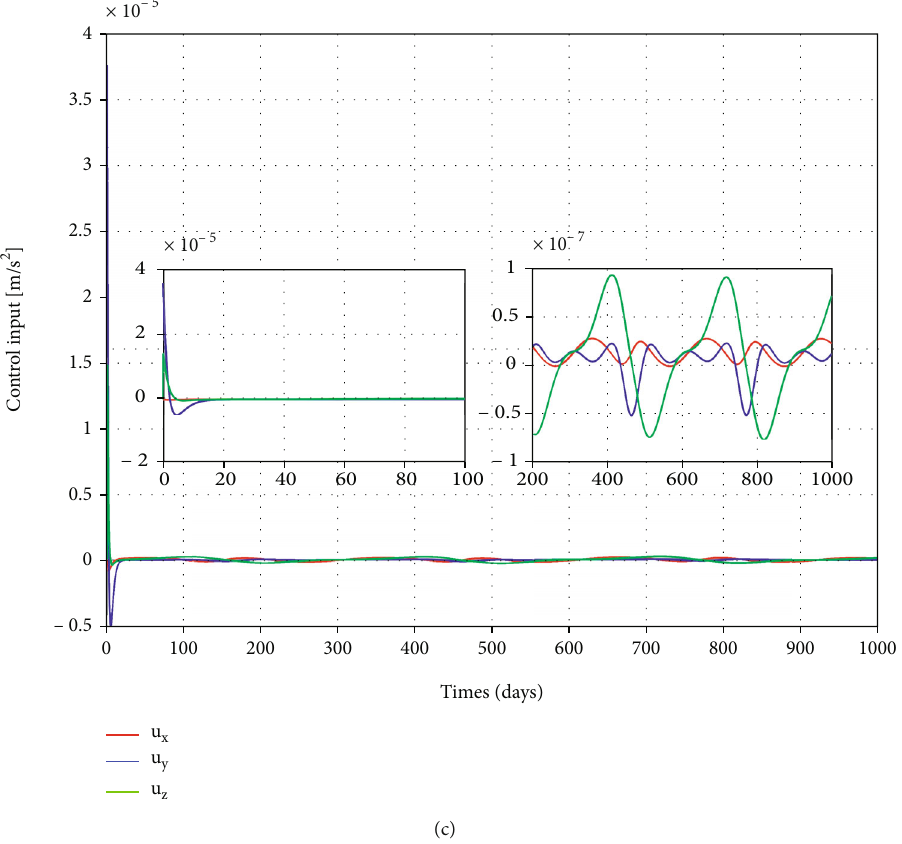
Figure 11: Time histories of the control input (Follower 1) ((a) PID; (b) FTSMC; and (c)